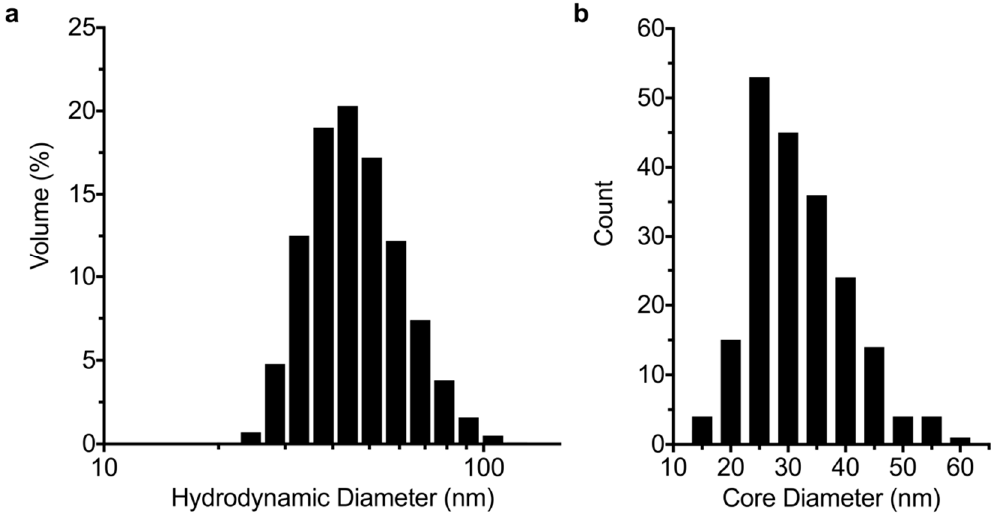
Figure 2. ( a ) Hydrodynamic and ( b ) TEM core diameter distributions of MCP 3. The hydrodynamic size distribution is given by volume. The TEM size distribution is based on the measurement of 200 multicore particles of MCP 3. The y-axis of the histogram in b gives the number of magnetic nanoparticles